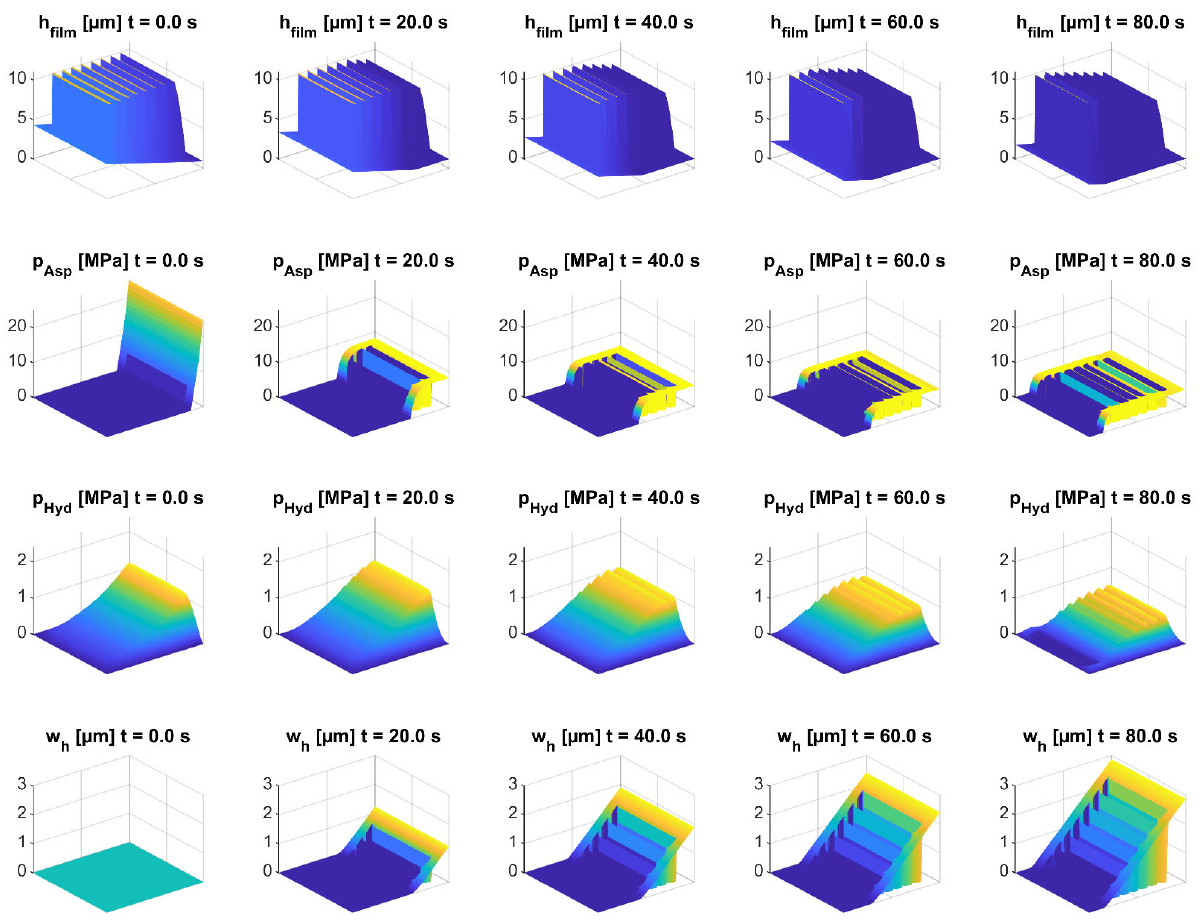
Figure 8. Plot of the time dependent lubrication gap height, asperity contact pressure, hydrody ‐ namic pressure, and wear height for a texture height of h t = 10 μ m.